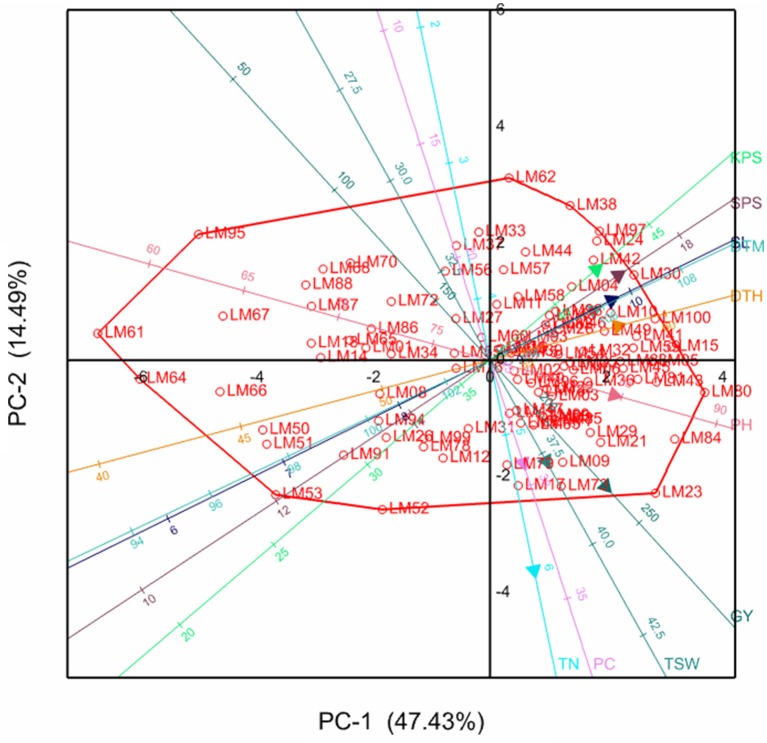
Principal component biplot showing genotypic grouping under optimum conditions. DTH, days to 50% heading; DTM, days to maturity; GY, grain yield per plot; SL, spike length; KPS, number of kennels per plant; PC, proline content; PH, plant height; TN, number of productive tillers; SPS, number of spikelets per spike; TSW, thousand seed weight.